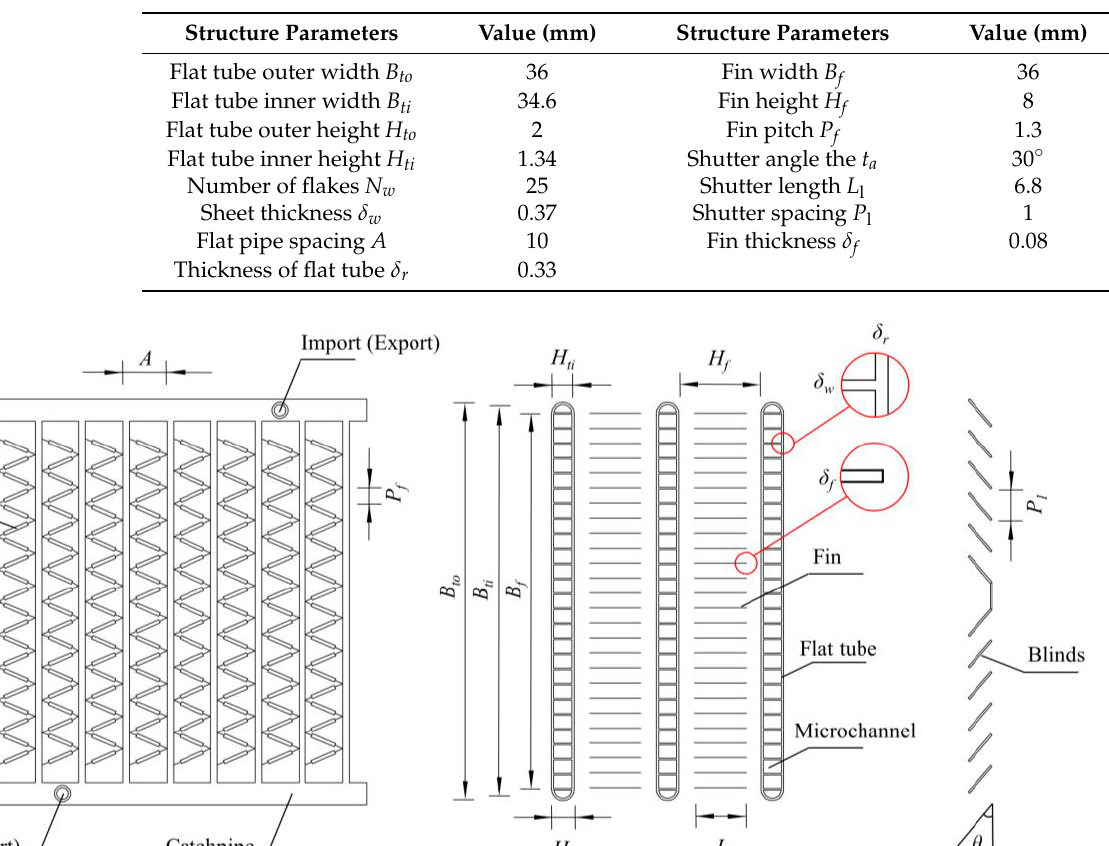
Table 4. Microchannel heat exchanger’s structural size parameters.